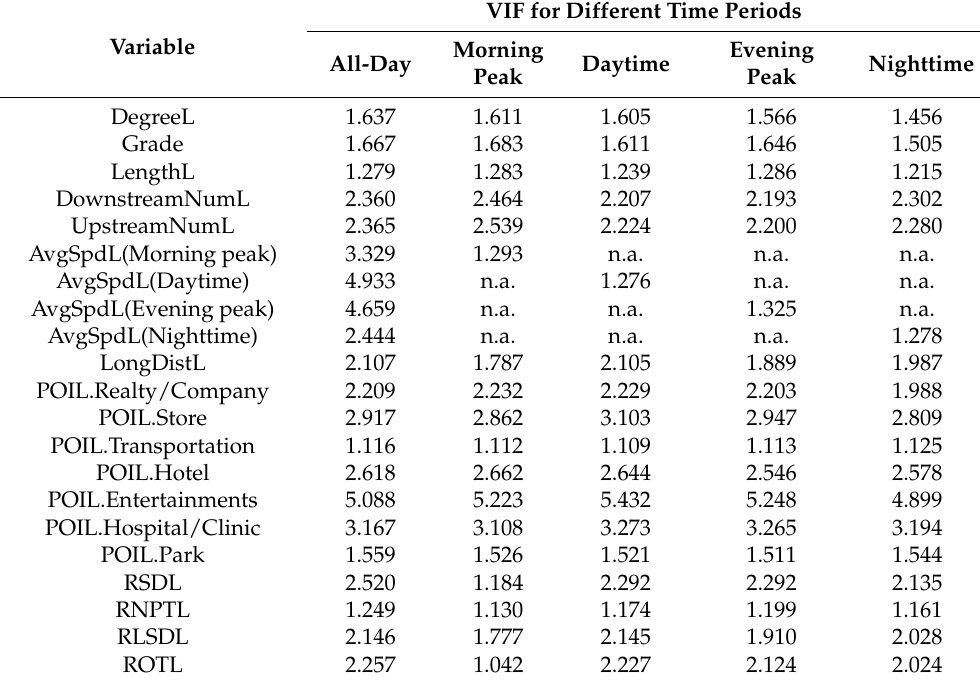
Table 3. Collinearity detection of the factors affecting DRS incomes.